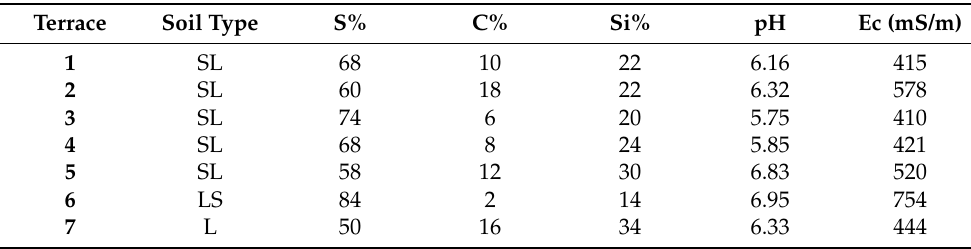
Table 2. Soil texture (sand%, clay% and silt%), soil pulp pH and electrical conductivity (mS/m) of seven selected terrace fields.